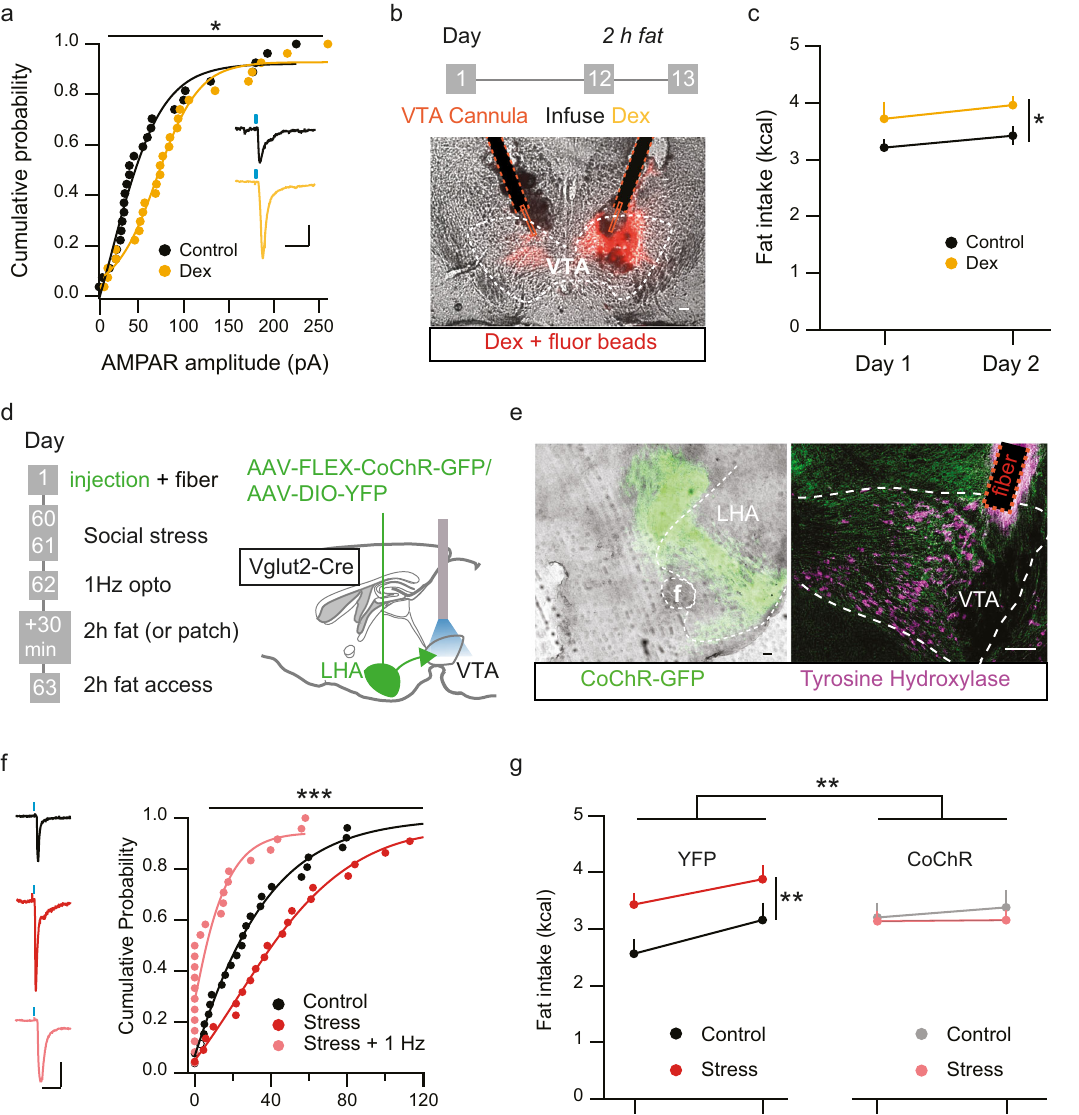
Fig. 5 | Strengthening or weakening of LHA glu -VTA synaptic transmission respectively mimics and prevents stress-driven fat intake in a limited access model.a Opto-evokedAMPARamplitudesatLHA glu -VTA DA synapsesareenhanced by Dexamethasone (Dex) infusion ( n cells group=27, KS test, D =0.37, p =0.036). Example traces,scalebars:25pA,25ms. b Experimentaltimelineand schematicof in vivo local Dex infusion in the VTA. Below: Representative example of cannula placementwithinfusionsitevisualizedbyinfusionof fl uorescentbeads(red).Scale bar: 100 µ m. c Fat intake (kcal) overall increases in a 2h limited fat access model afterinvivodexinfusion(averages+SEMs, n animalscontrol=6, n animalsDex=5, RM Two-way ANOVA. Main effect Dex, F (1,9) =7.03, p =0.03). d Timeline and schematic of in vivo optogenetic reduction of stress-potentiated LHA glu -VTA DA synapses. e Representative example images of coronal sections. Left: example of LHA CoChR (green) virus expression. Right: example of bilateral in vivo optoge- netic fi ber placement above the VTA with TH staining (purple) for dopamine